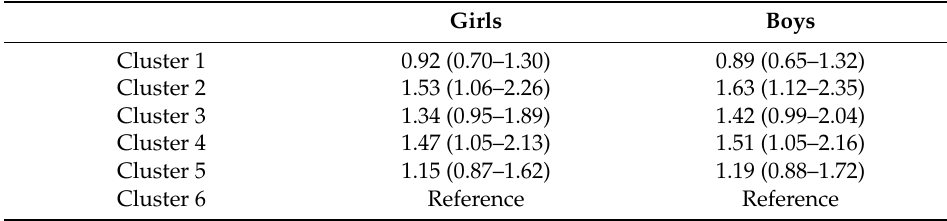
Table 3. Binary logistic regression analysis between indicators of dietary habits, practice of physical activity, sedentary behavior and excess body